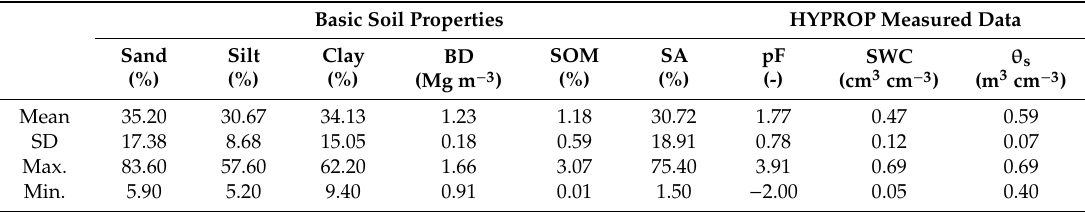
Table 1. Characteristics of the soils used in this